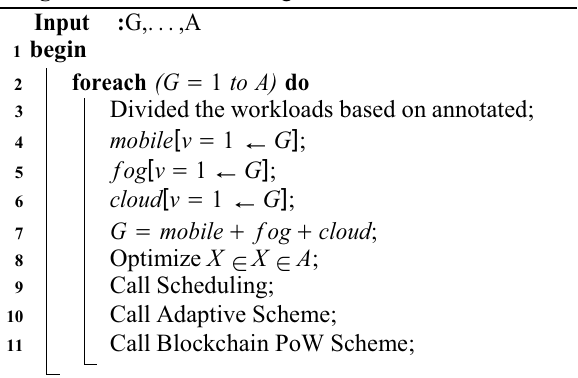
Algorithm 1: DRLBTS Algorithm